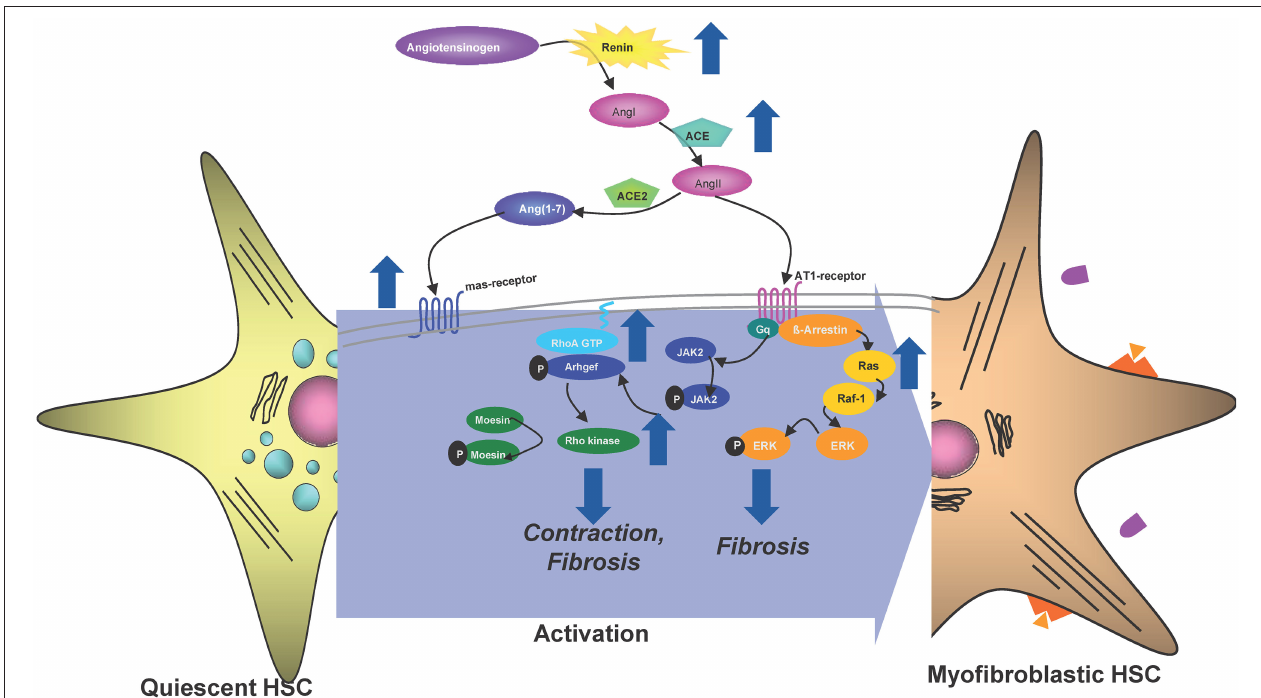
FIGURE 11 | Renin-angiotensin-system (RAS) in liver fibrosis. Angiotensinogen is cleaved by renin into Angiotensin I (Ang I), which is further converted to Angiotensin II (Ang II) by Angiontensin-Coverting-Enzyme (ACE). Ang II is the agonist of AT1R, which signals G-protein dependent via Janus-kinase 2 (JAK2), Argef1/RhoA/Rho-kinase. This constitutes the classical RAS, which is known to lead to activation of hepatic stellate cells (HSC) and thereby to fibrosis and their contraction. The G-protein coupled pathway is terminated by beta-arrestin-2 binding to AT1R, which may terminate the contraction, but still may induce fibrosis via ERK-activation. Ang II may be further metabolized to Ang1-7 by ACE2, which represents the alternative RAS-pathway. The alternative RAS-pathway may block contraction via mas-receptor (masR) stimulation. The role of masR and beta-arrestin-2 are still under investigation and be crucial to elucidate the mechanisms in HSC, but also may offer therapeutic options for liver fibrosis and portal